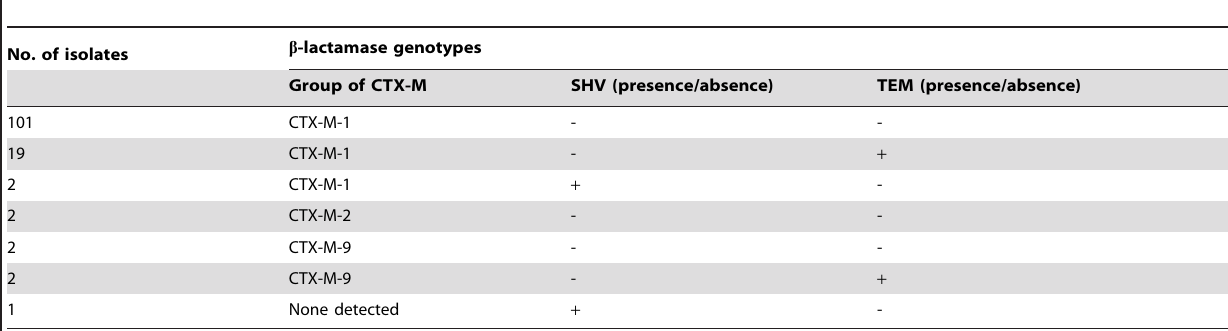
Table 1. Distribution of b -lactamase genotypes among 129 ESBL-producing isolates from Franklins gulls.